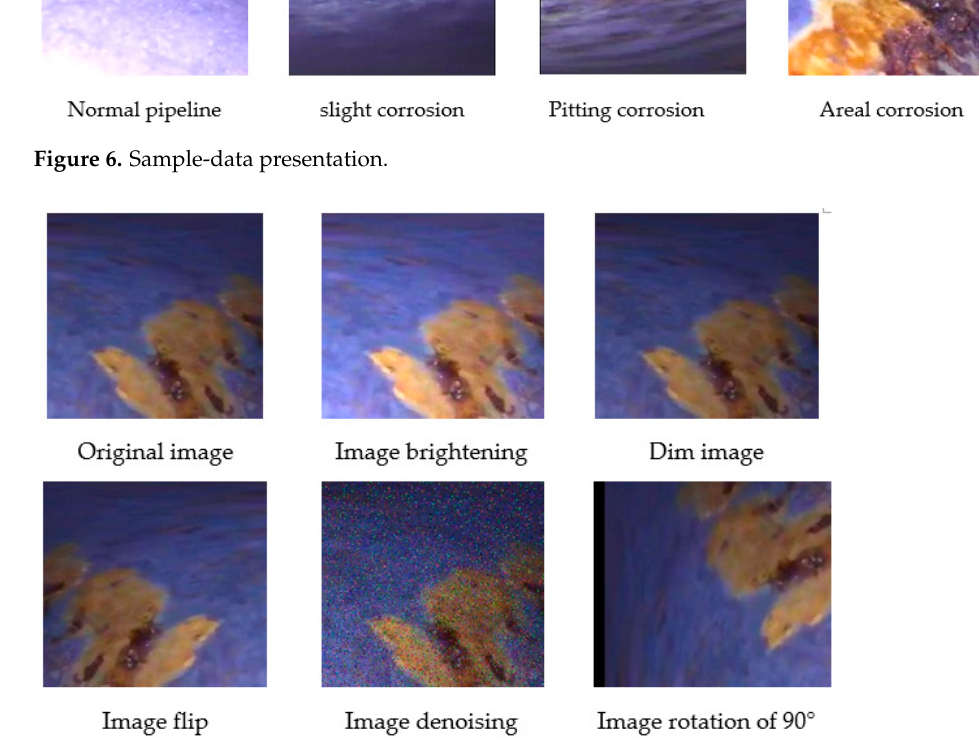
Figure 7. Data enhancement . Figure 7. Data Table 1. Sample size before and after enhancement.